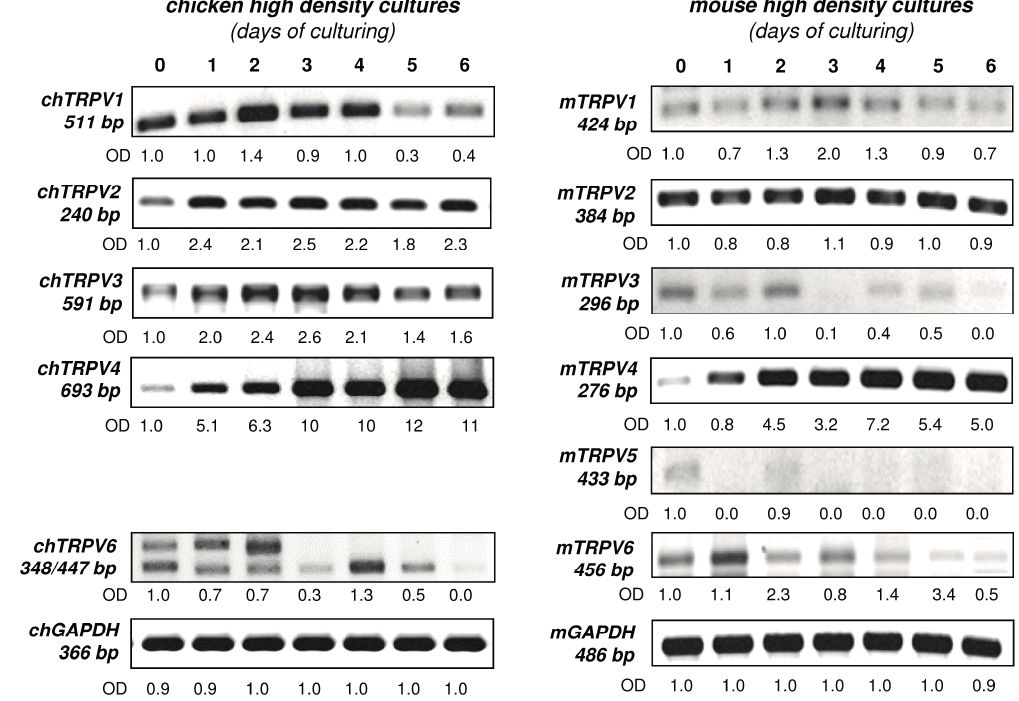
Figure 2. mRNA expression of TRPVs in chicken (ch) and mouse (m) HD cultures.